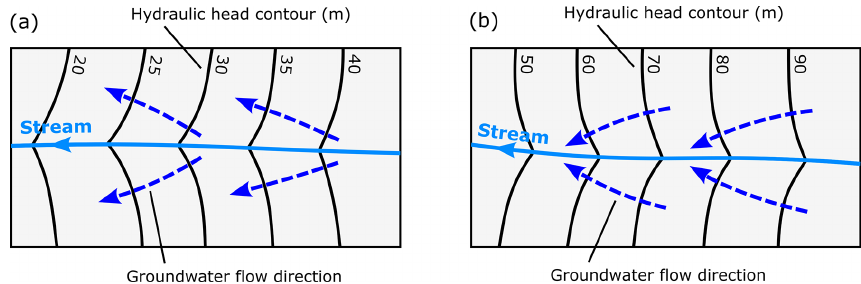
Figure 4. Schematic diagram showing hydraulic head contours and groundwater flow directions in the horizontal plane for (a) losing and (b) gaining stream conditions (after Winter et al. (1998)).